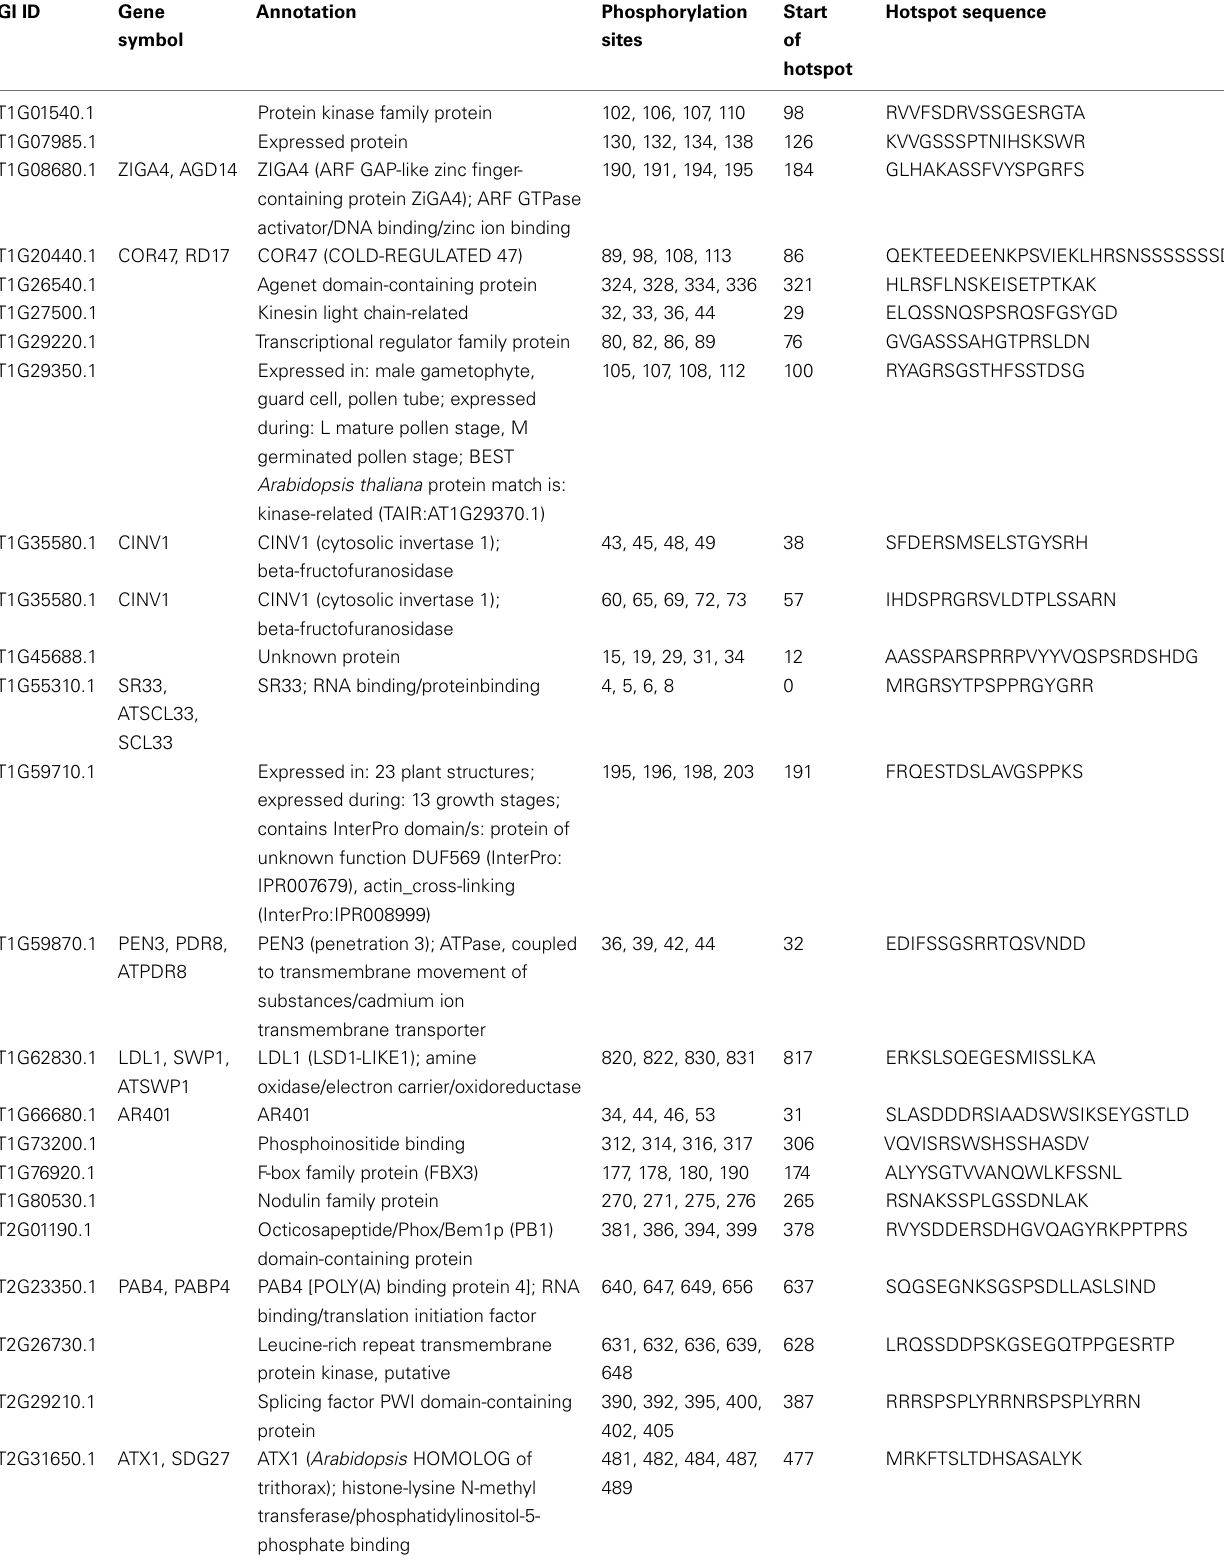
Table 1 | Arabidopsis P-hotspot containing proteins detected based on experimentally identified phosphorylation